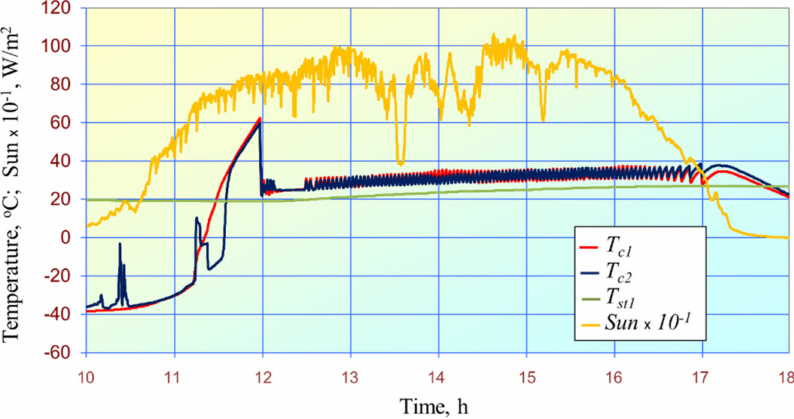
Figure 13. Operating process stabilisation of hydraulic circuit of collectors after the heating agent freezing at